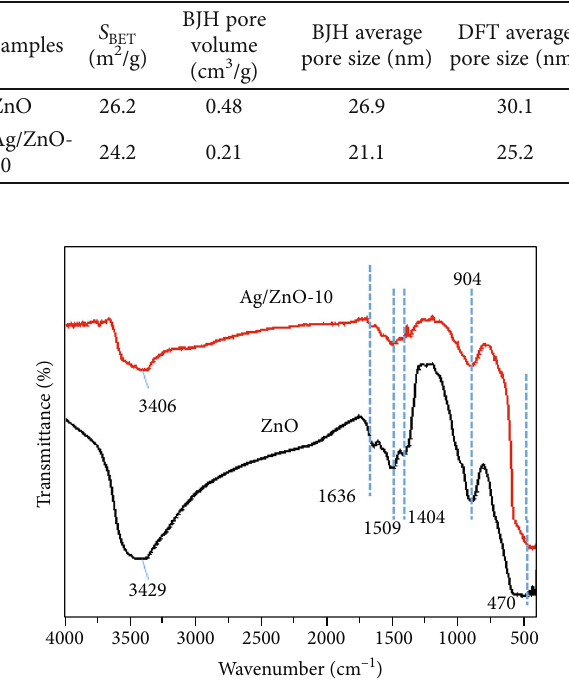
Figure 4: FTIR spectra of the ZnO and Ag/ZnO-10